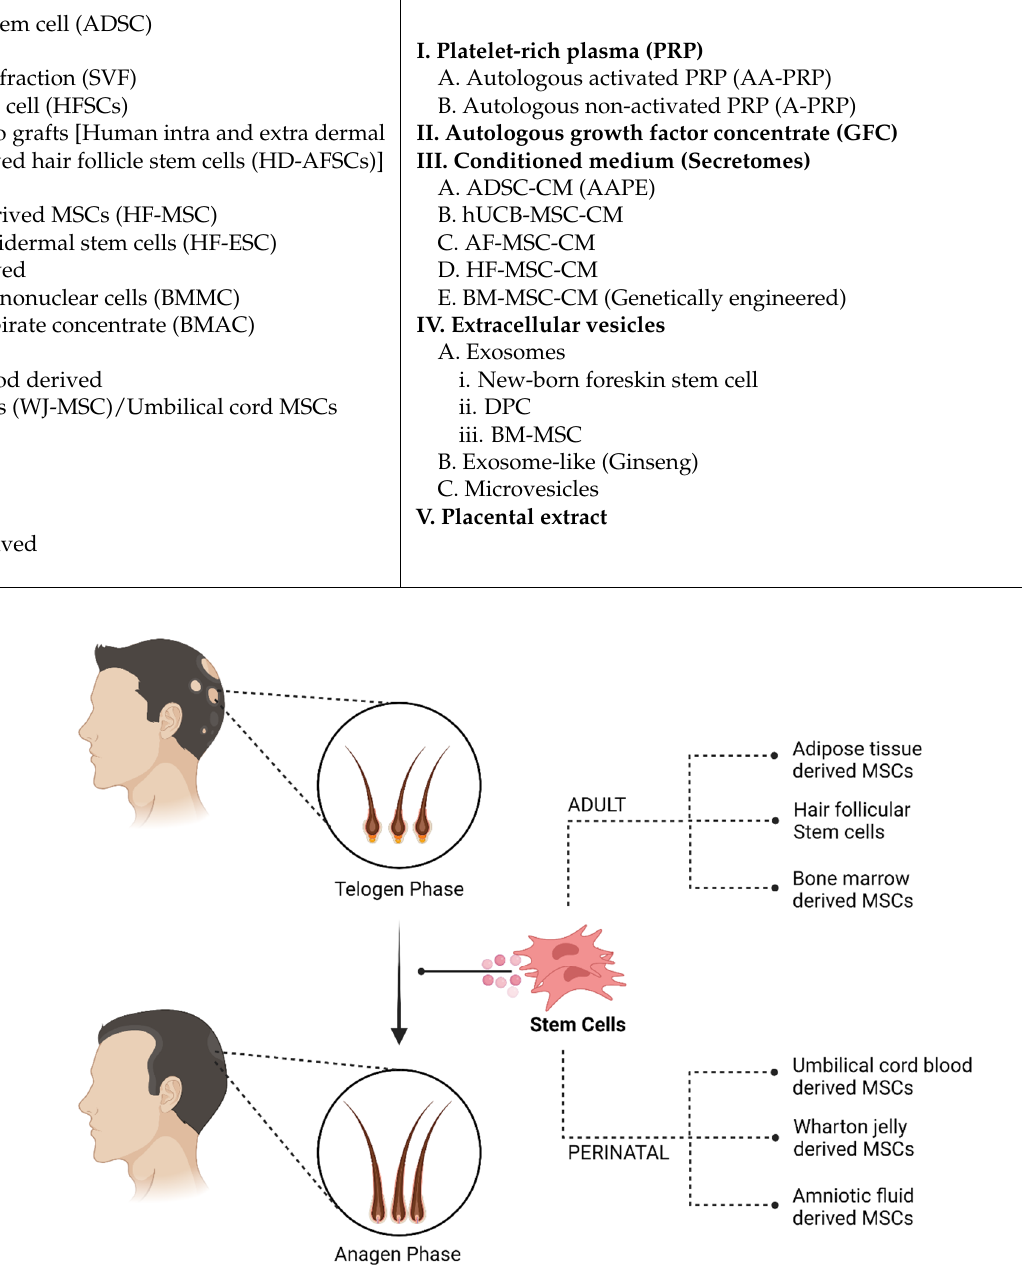
Table 1. “A La Mode Classification” of regenerative therapies [37–60]. Stem Cell-Rich